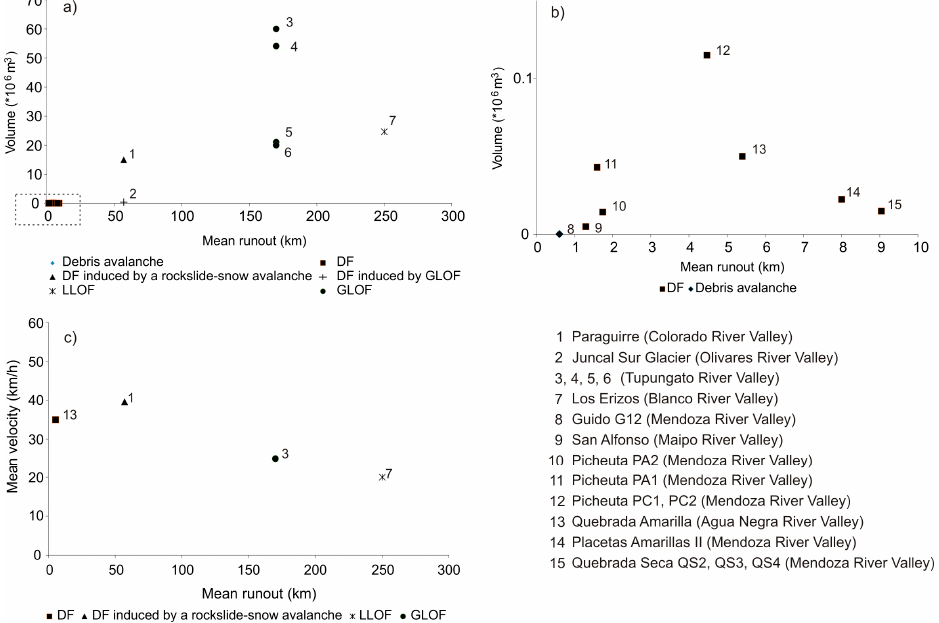
Figure 4. Parameters of recorded historical events when these parameters were estimated ( a ) relation between volume and mean runout; ( b ) zoom of events in the rectangle in a. ( c ) Relation between mean velocity and mean runout.